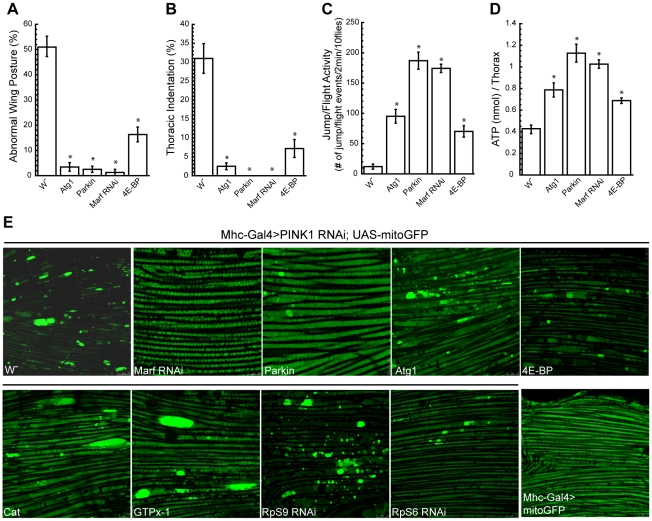
Overexpression of Atg1 rescues PINK1 mutant phenotypes.Overexpression of Atg1 in the muscle of PINK1B9 mutants rescued their abnormal wing posture (A), thoracic indentation (B), jump/flight activity (C) and muscle ATP level (D). Data are presented as mean ± s.e.m. Statistical significance was determined by Student's t test (*P<0.001). (E) Atg1 overexpression did not completely rescue the mitochondrial aggregation phenotype in the muscle of PINK1 RNAi flies. mitoGFP was expressed in the muscle using Mhc-Gal4 driver to visualize mitochondrial morphology by live imaging. Wild type flies showed mitochondria of relatively uniform sizes (bottom right), while PINK1 RNAi flies had bright mitochondrial aggregates. Only the co-expression of Marf RNAi or Parkin OE was able to efficiently rescue the mitochondrial aggregation phenotype in the PINK1 RNAi background.